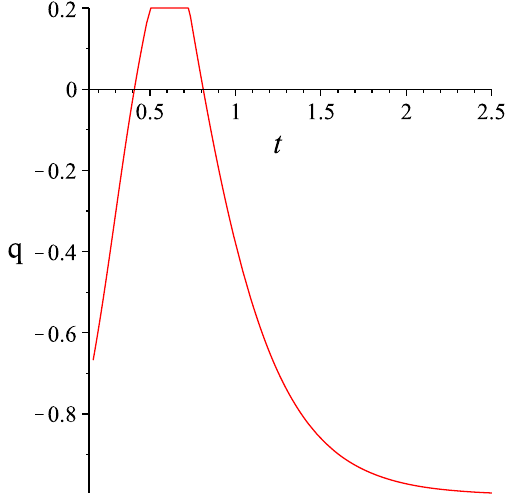
Fig. 3 The deceleration parameter q is plotted against t